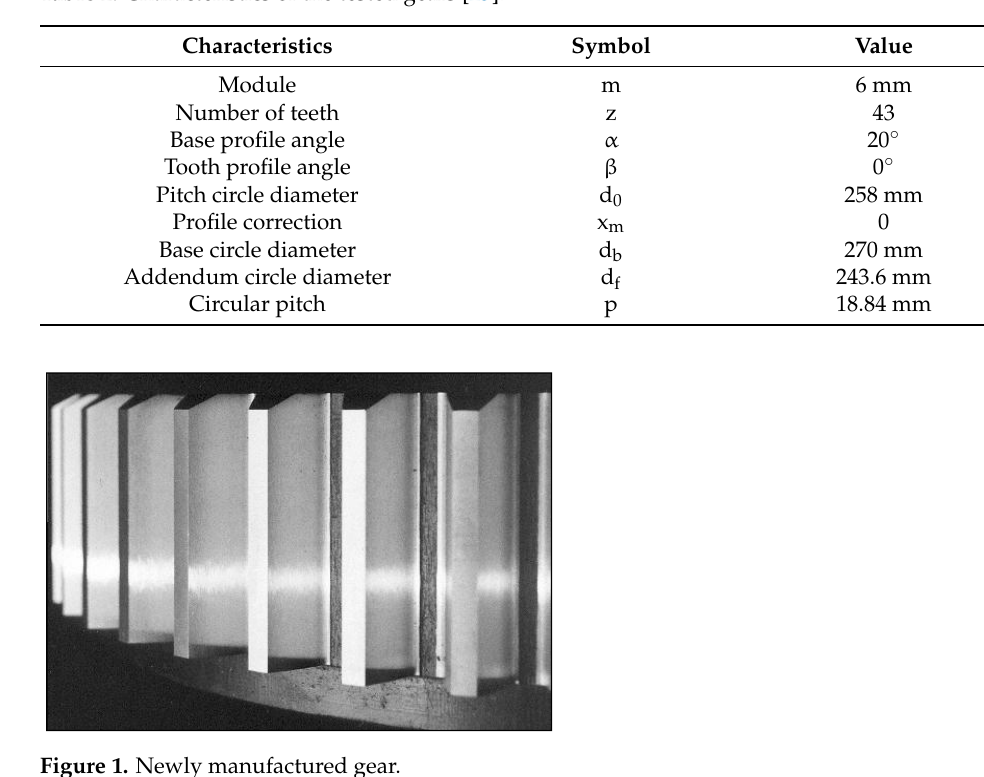
Table 2. Characteristics of the tested gears [25].